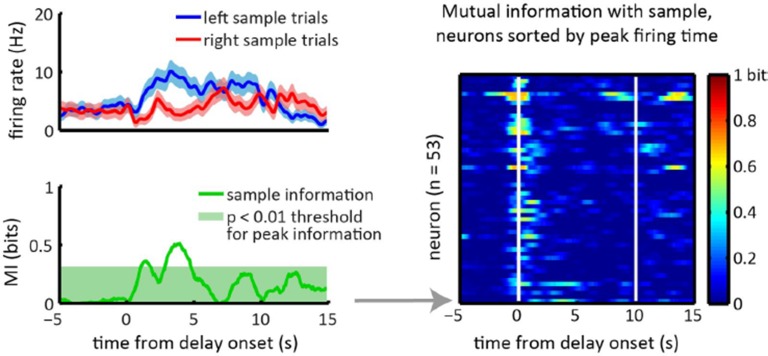
DOI:
http://dx.doi.org/10.7554/eLife.19507.014